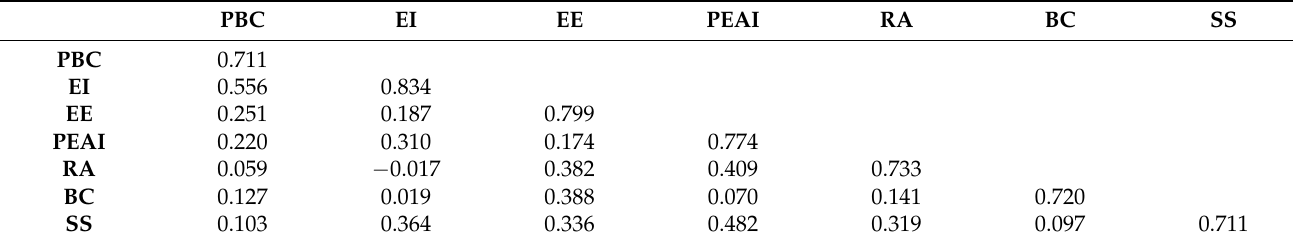
Table 2. Discriminant validity